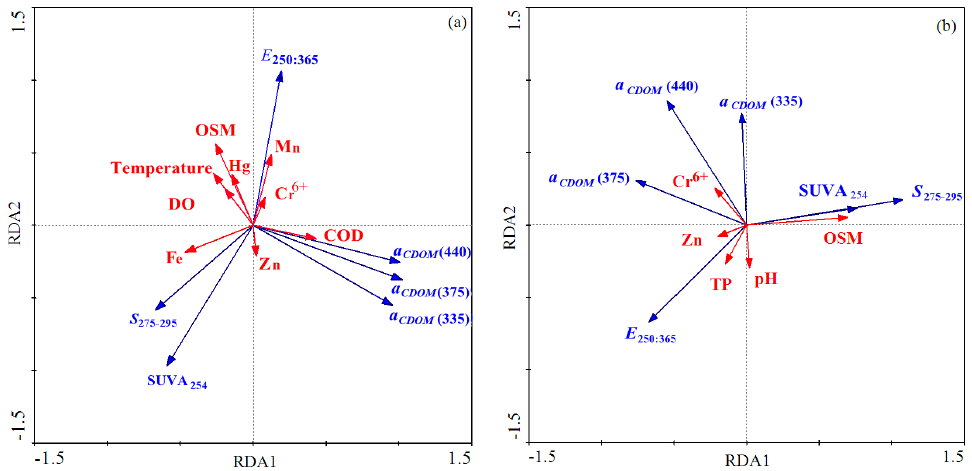
Figure 9. RDA of CDOM absorption and environmental factors: ( a ) in summer; and ( b ) in autumn.